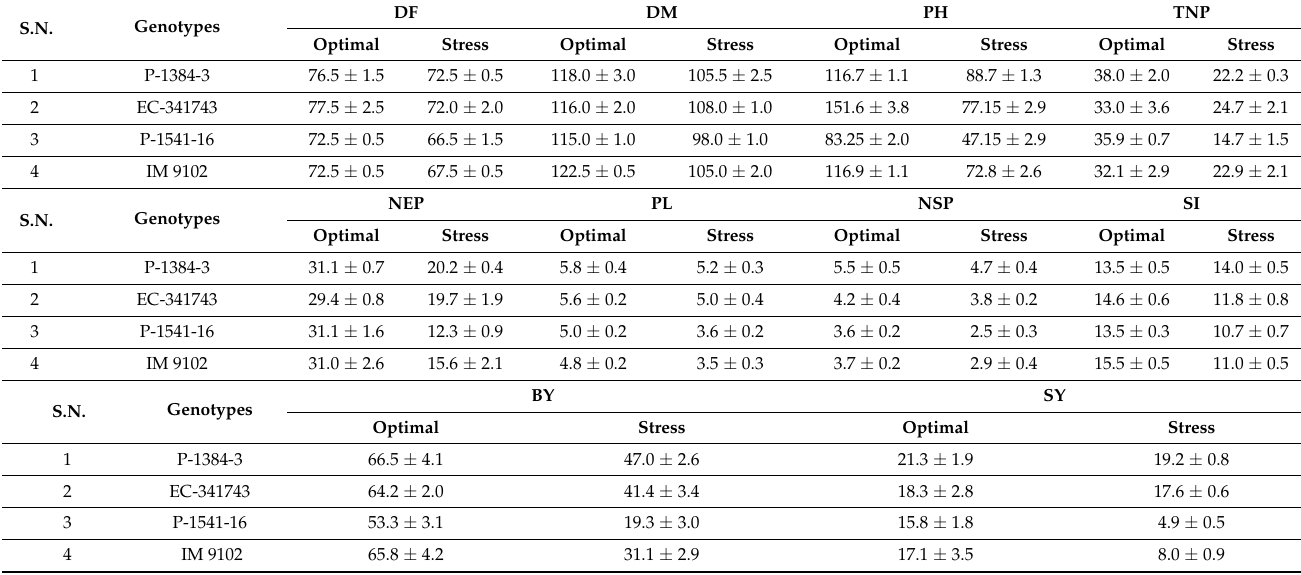
Table 2. Mean value of field pea genotypes for plant growth and yield component traits under control and heat stress conditions.